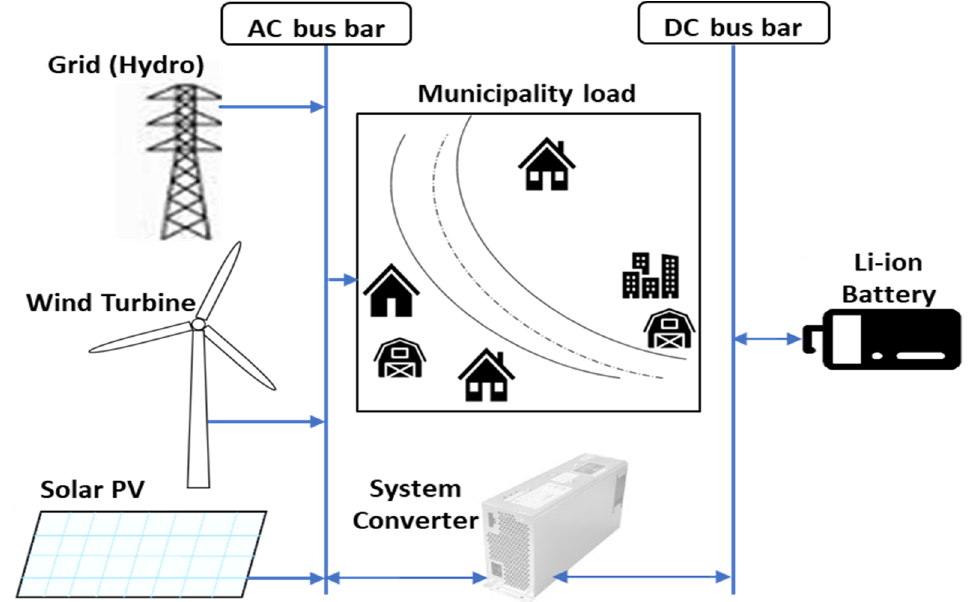
Figure 3. A system diagram for simulations with hydro represented as the grid.